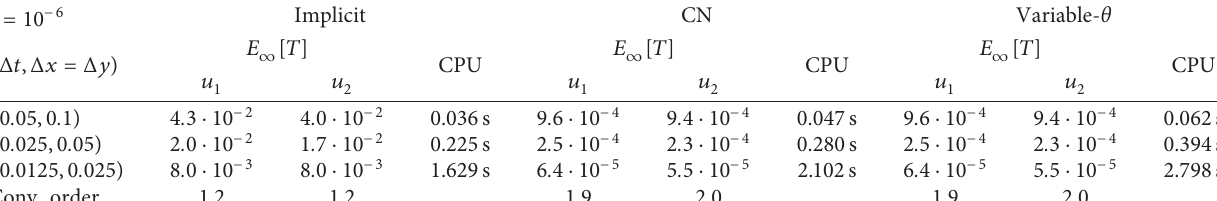
Table 2: L ∞ -error E [ T ] and the elapsed time (CPU) for the numerical solution of the Gray–Scott model in the 2D space: T � 1 . 0. ∞